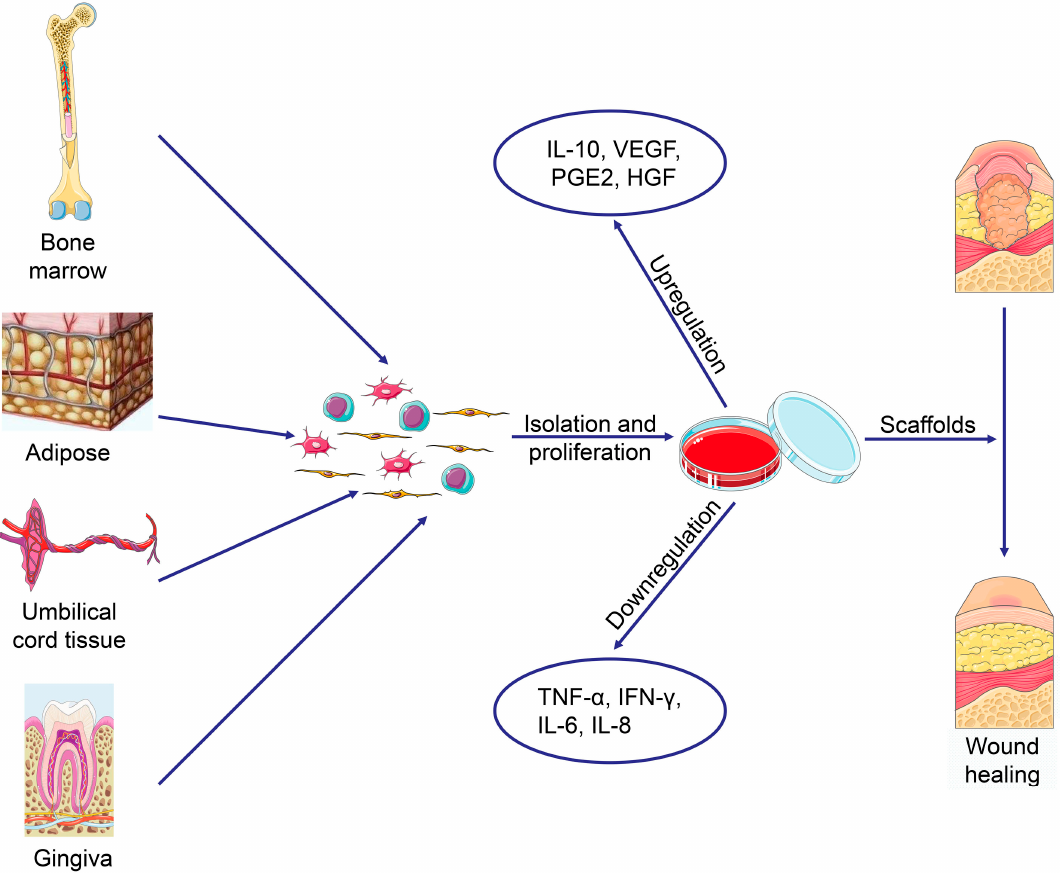
Figure 5. Strategies for wound healing: various mesenchymal stem cells (MSCs) are isolated and identified, and then the cells are augmented and differentiated in a specific culture condition. To realize the skin regeneration, MSCs secrete numerous factors to modulate inflammation and induce angiogenesis.